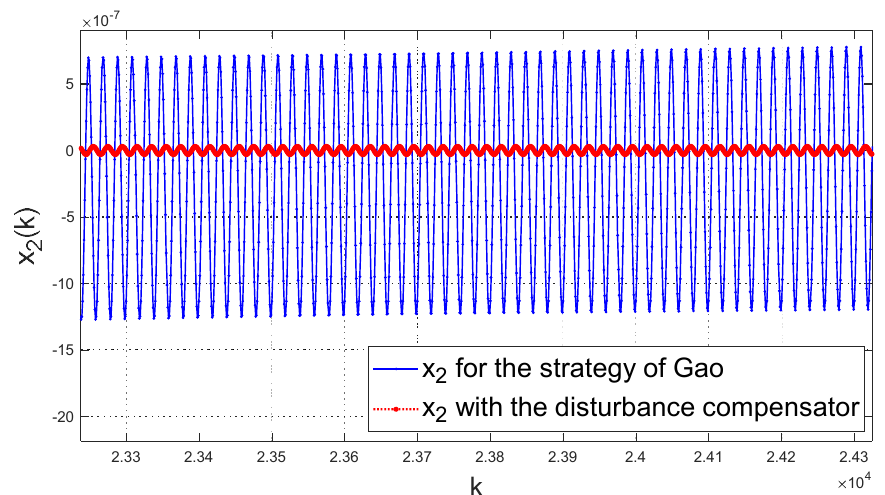
Figure 10. x 2 ( k ) for both control strategies in the sliding phase.